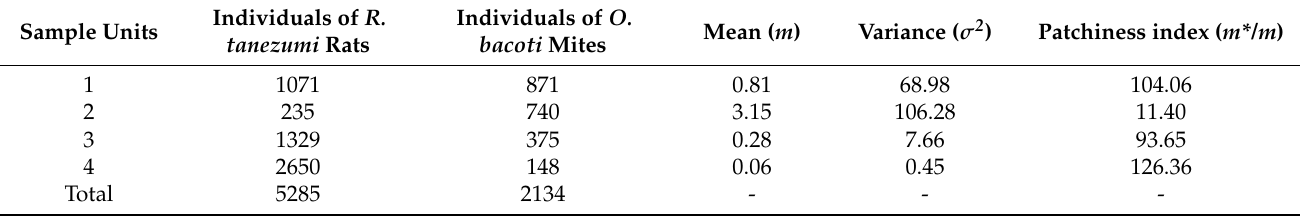
Table 9. The mean ( m ), variance ( σ 2 ) and patchiness index ( m*/m ) of O. bacoti mites on R. tanezumi rats in each recombined sample unit of Yunnan, Southwest China (1990–2015). Individuals of R. Sample Units